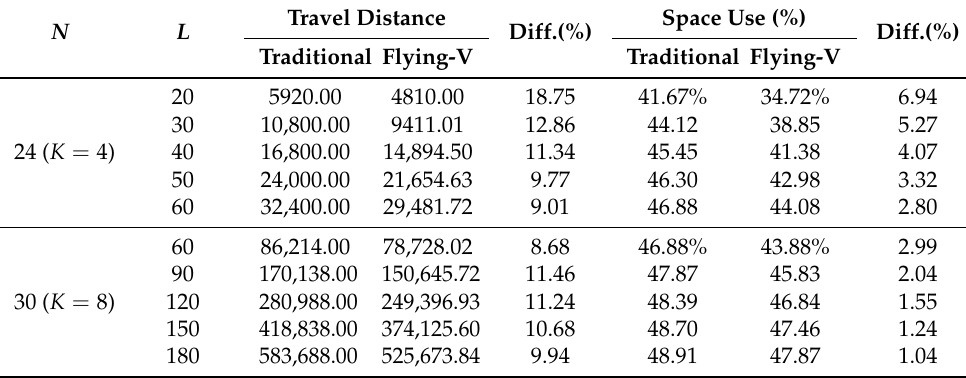
Table 14. Space use on different